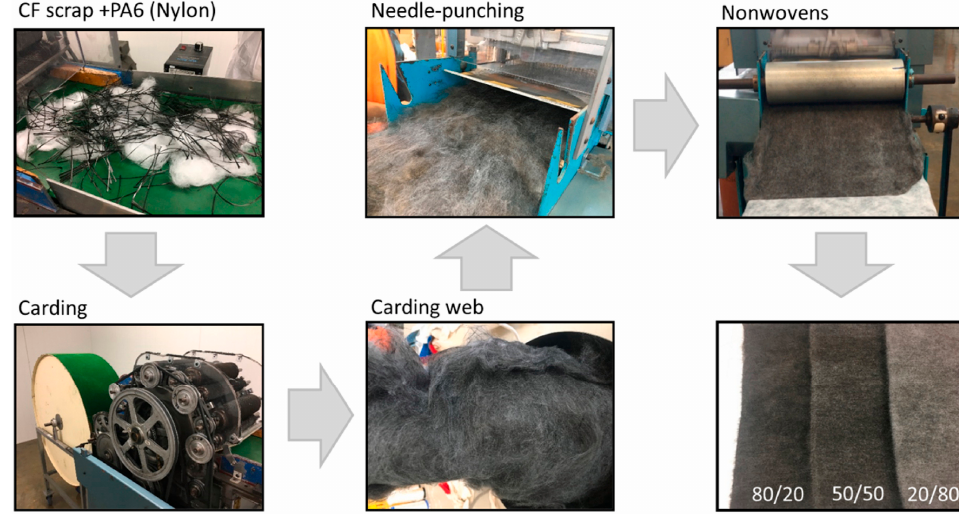
Figure 7. Production of carbon fiber/PA5 nonwovens. From [119], copyright (2021), with permission from Elsevier.